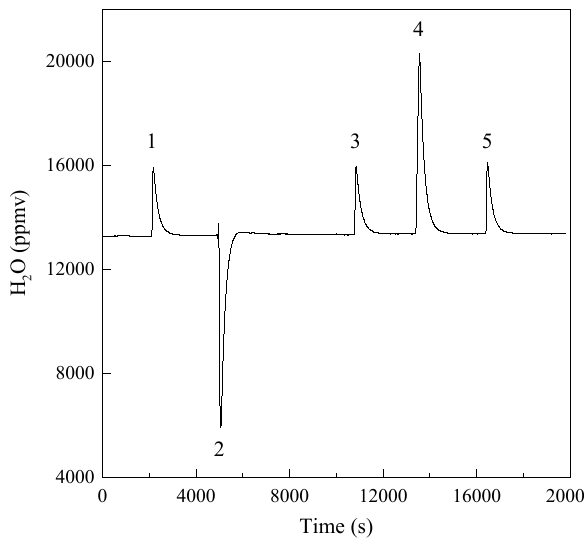
Figure 7. Water vapour evolution during a measurement sequence. Peaks 1, 3 and 5 are 0.5µl injections of ST-08 standard water. Peak 4 corresponds to the released fluid inclusion water. Depression 2 cor- responds to the exchange between the empty and the loaded copper